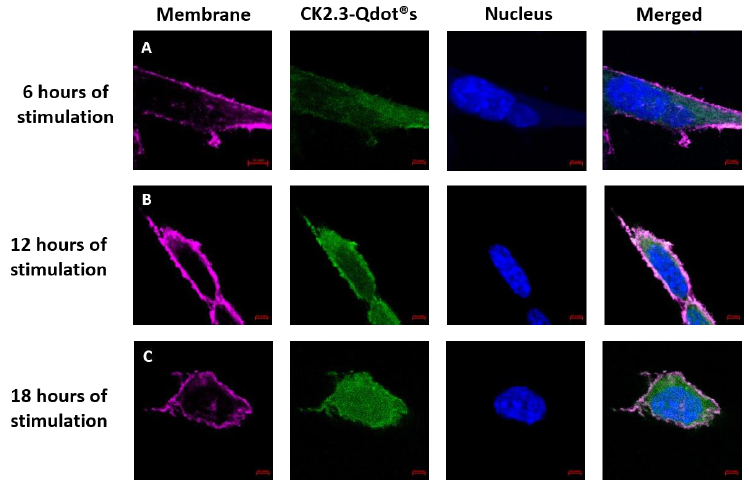
Figure 7. Uptake of CK2.3-Qdot® s (green) by C2C12 cells at 6 h, 12 h, and 18 h. Following stimulation, cells were fixed using 4.4% PFA and the plasma membrane (magenta) and nucleus (blue) of the cells were stained using FM™ 4-64FX and Hoechst; respectively. Images of cells taken using 63×/1.4 objective at ( A ): 6 h, ( B ): 12 h, and ( C ): 18 h show the localization of CK2.3-Qdot®s within the cell.